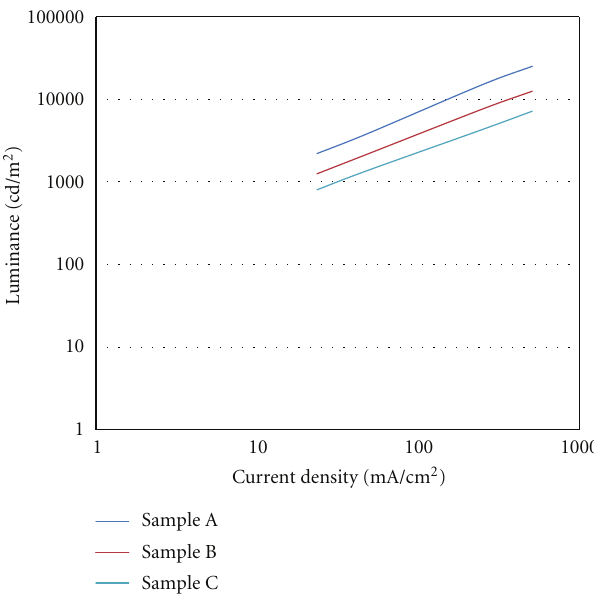
Figure 3: J-L characteristics in all RGB-type